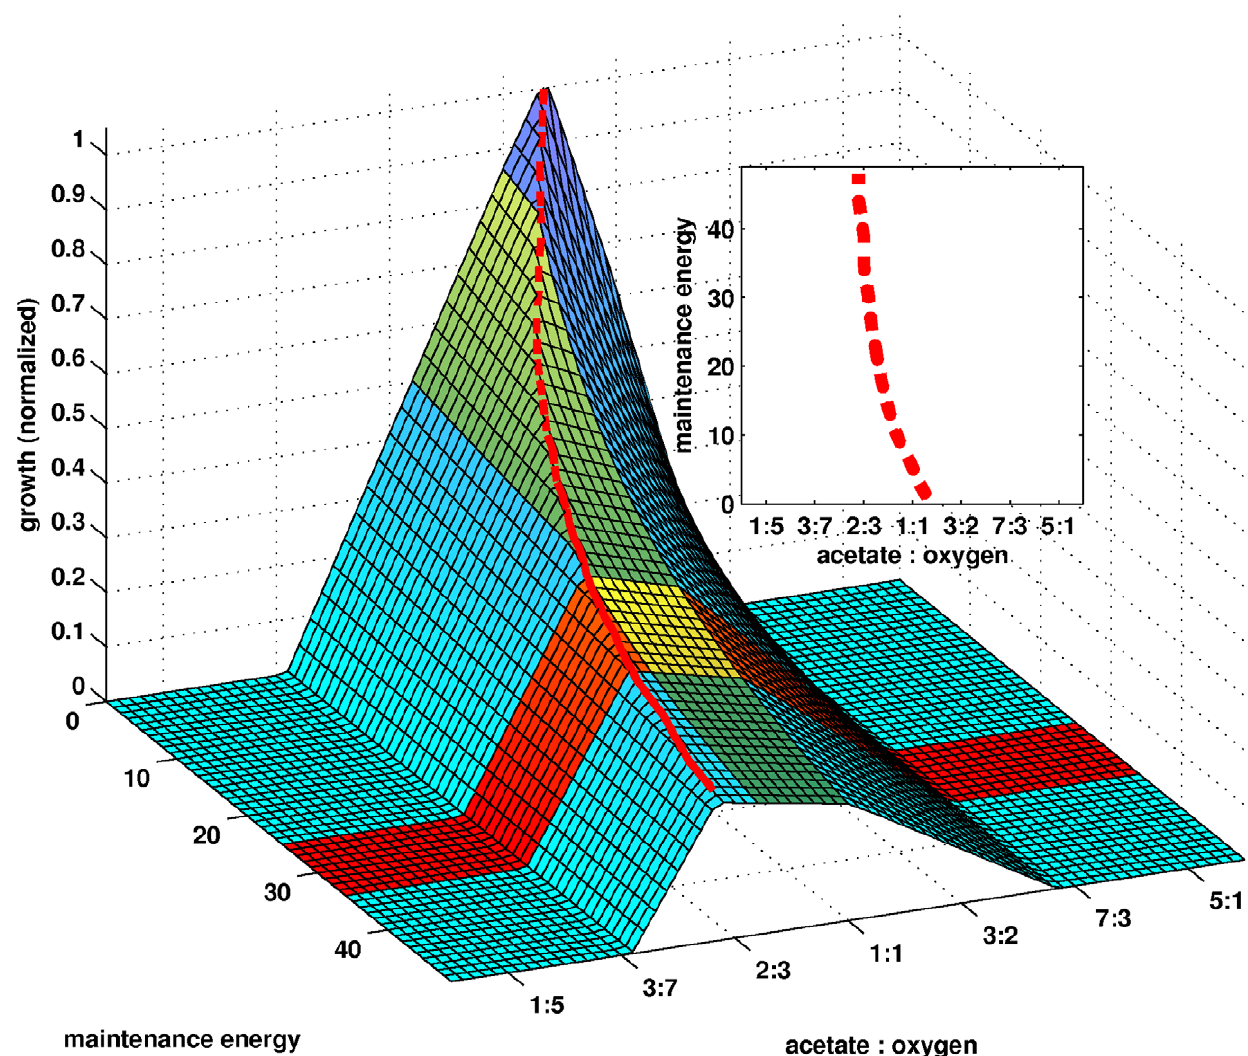
Figure 4. Theoretical analysis of aerobic growth on acetate. The surface represents the theoretical maximum growth of Natronomonas pharaonis as a function of two parameters: (1) the acetate to oxygen ratio and (2) the maintenance energy (in m mol ATP per D OD : ml). The green shaded region corresponds to experimentally observed values of the former (i.e., acetate:oxygen), while the orange shaded region corresponds to experimentally determined values of the latter (i.e., maintenance energy). Clearly, for different values of the maintenance energy, theoretical maximum growth is achieved at different acetate to oxygen ratios. This optimality relationship is represented by the red broken curve. A projection of this into the x,y-plane is shown in the inset.